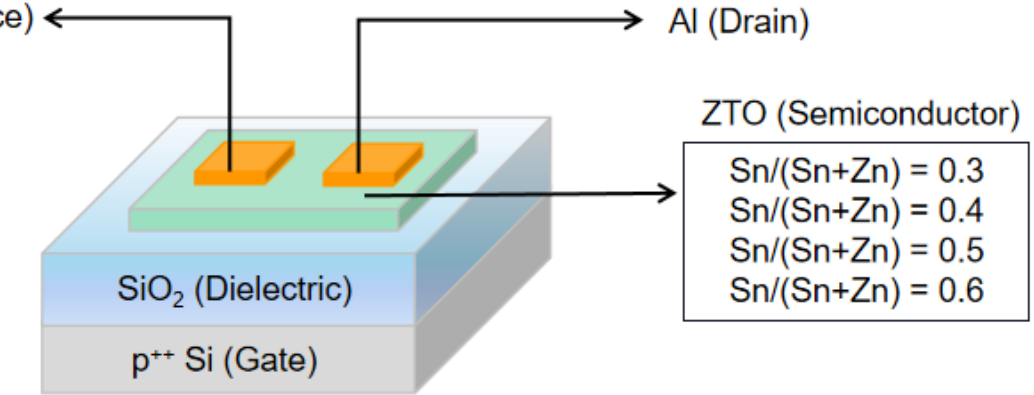
Figure 1. Illustration of structure of ZTO TFTs fabricated in this study. The Sn/(Sn+Zn) ratio is controlled from 0.3 to 0.6 in ZTO semiconductors.